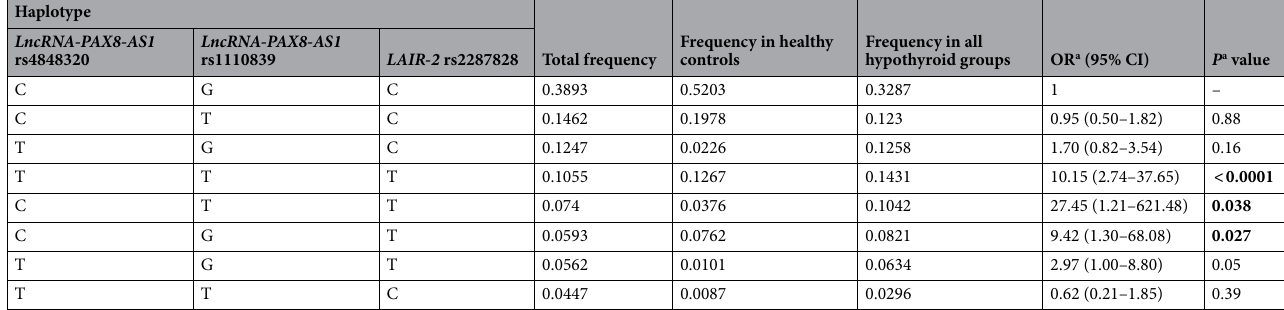
Table 4. Association of haplotypes with hypothyroid risk. Healthy controls, n = 95, all hypothyroid patients, n = 210. a adjusted by age and sex in a logistic regression model using SNPstats online software. Global haplotype association manifested at P < 0.0001. T allele is the risk one for all SNPs. P values in bold means statistical significance between groups ( P <